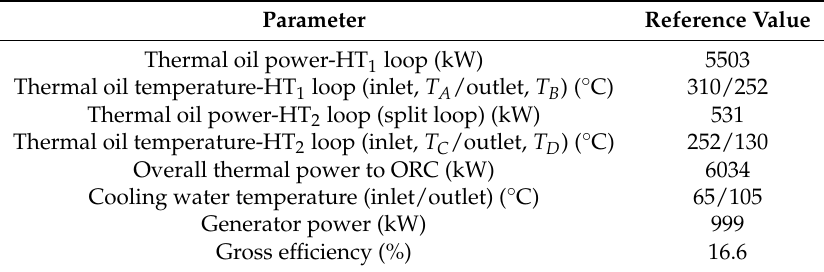
Table 1. Design data for the ORC plant in Cremona. The data are from